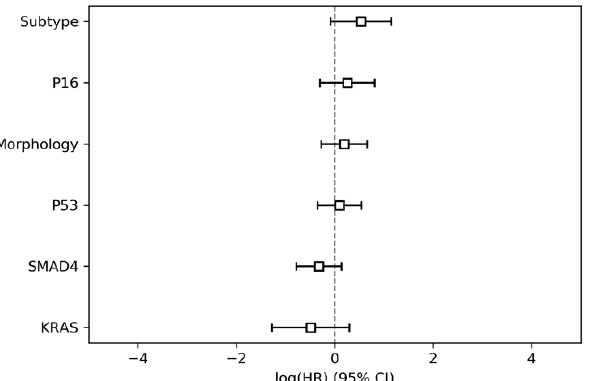
Figure 2. Hazard ratios for parameter group 2 (histo-morphologic and genetic parameters).